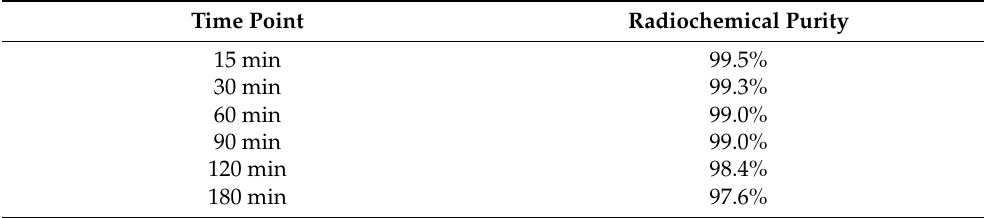
Table 1. Stability of [ 11 C]MPC-6827 in human serum sample ex vivo